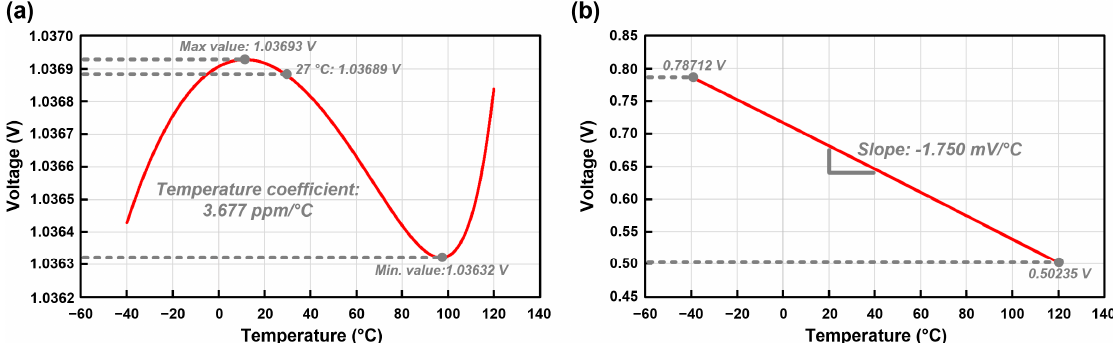
Figure 8. Simulation results of the bandgap reference. ( a ) Temperature sweep of output bandgap reference voltage (VBGR); ( b ) Generated temperature sensor voltage (VTEMP).